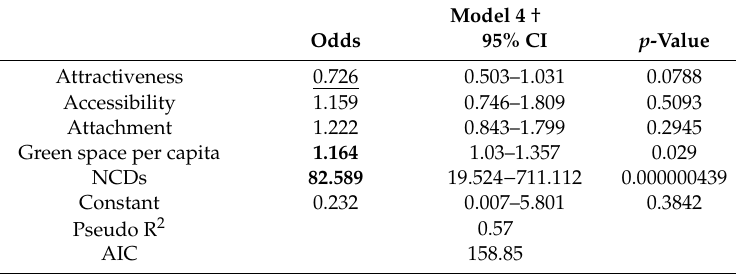
Table A1. Mediator model results—associations of NCDs with ParkRx (Model 4).